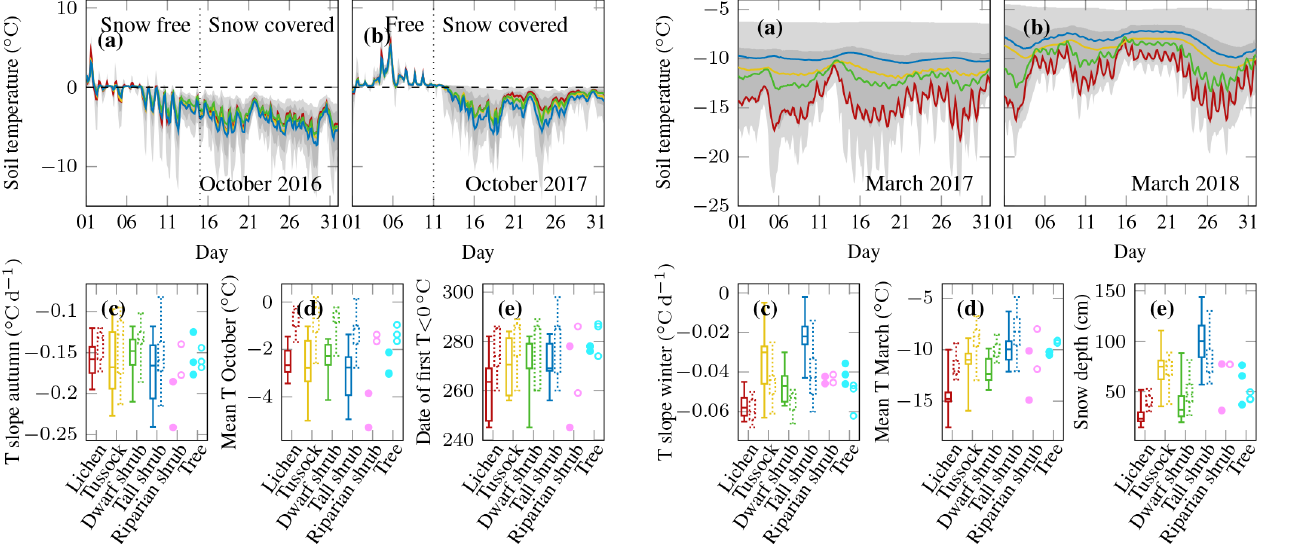
Figure 5. Topsoil temperature series of (a) October 2016 and (b) October 2017 representing autumn of the two different mea- surement periods; mean of all measurements below four different vegetation types in colour, the range of all single sensors in light grey, and the range of all sensors between the 10th and 90th per- centiles in darker grey; the beginning of snow accumulation was derived from the Trail Valley Creek weather station albedo data; box plots of all measurements per vegetation type with boxes of the first period left and the second period right and dotted; for riparian shrubs and trees all single observations are shown with filled sym- bols for the first period and open symbols for the second; (c) rate of cooling in autumn; (d) mean October topsoil temperature; (e) date when the freezing is completed.